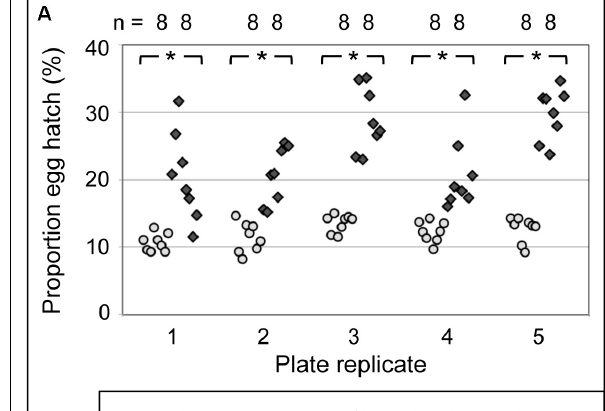
ranging from 0.76 to 0.89 ( Supplementary Table S5 ).